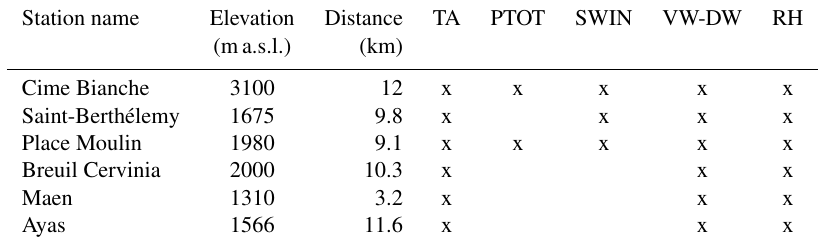
Table B1. Characteristics of the meteorological stations used for the spatial interpolation with the MeteoIO library and measured parameters. TA: air temperature; PTOT: precipitation (OTT); SWIN: incoming shortwave solar radiation; VW-DW: wind speed and direction; RH: relative humidity. The stations belong to the regional meteorological network of the Aosta